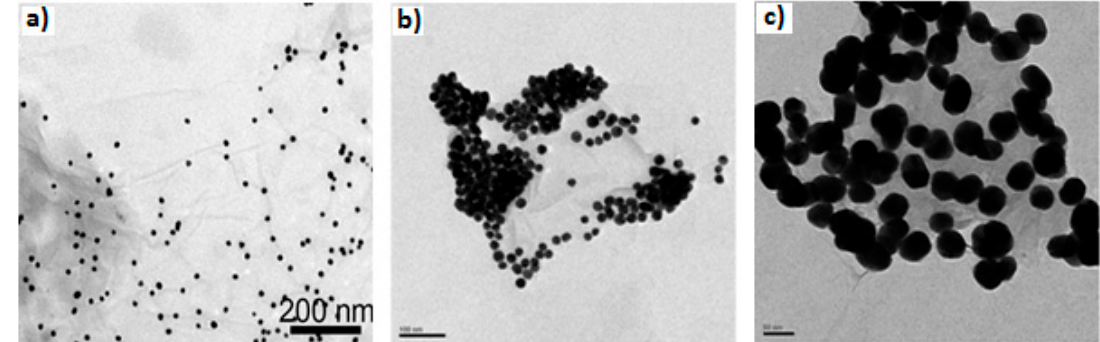
Figure 4. TEM image of GO–AuNPs composites ( a ) in situ growth, adapted from [81], with permission from ©2014 Nature Publishing Groupand ( b ) and ( c ) ex situ decoration of 20 nm and 40 nm AuNPs on GO sheets respectively, adapted from [82], with permission from ©2010 Royal Society of Chemistry.